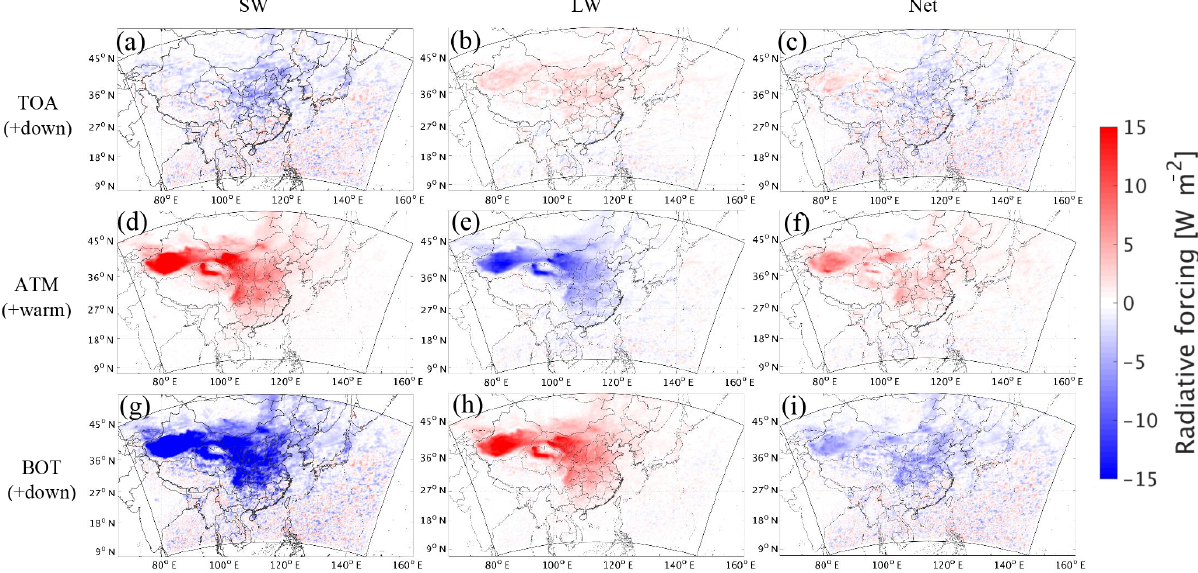
Figure 8. Spatial distributions of the all-sky SW (left panels), LW (middle panels), and net (right panels) radiative forcing at the top of the atmosphere (TOA, a–c ), within the atmosphere (ATM, d–f ), and at the bottom of the atmosphere (BOT, g–i ).